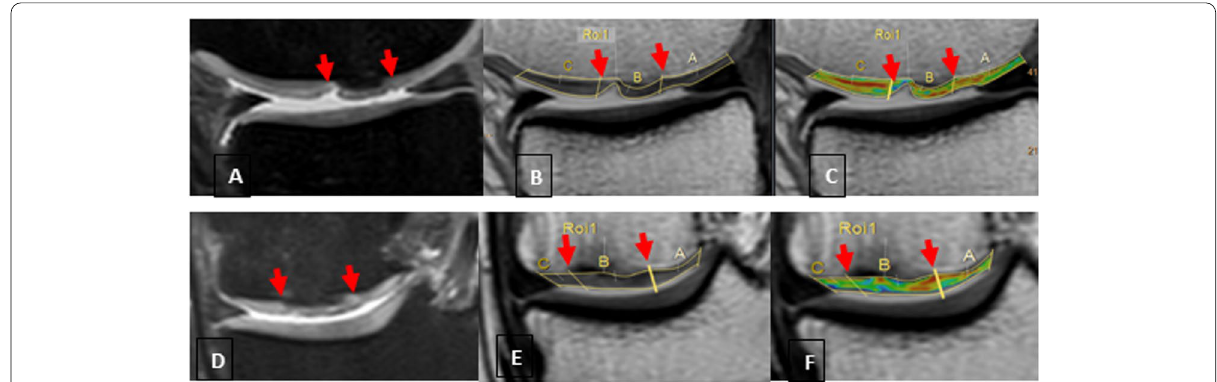
Fig. 3 T2 measurements of a treated lesion on medial femoral condyle (images from the same patient). a and d : Fat suppressed PD VISTA (Proton Density Volume Isotropic Turbo spin echo Acquisition) in sagittal and coronal planes, respectively. Arrows indicate the boundaries of the lesion. b and e : The same lesion on the first echo of multi‑echo sequences as marked by arrows on sagittal and coronal images, respectively. c and f : Colour maps of the same lesion on sagittal and coronal planes,